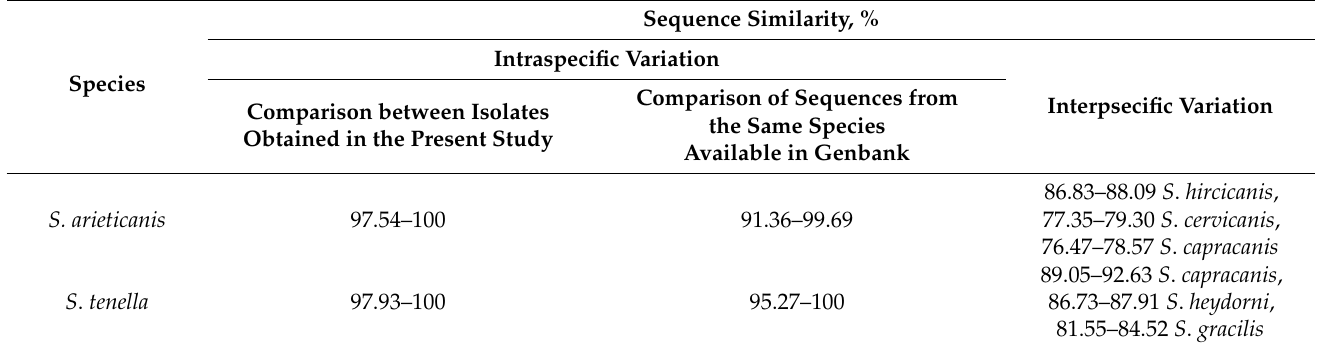
Table 3. The identification of S . arieticanis and S . tenella using the nPCR method applied in the present